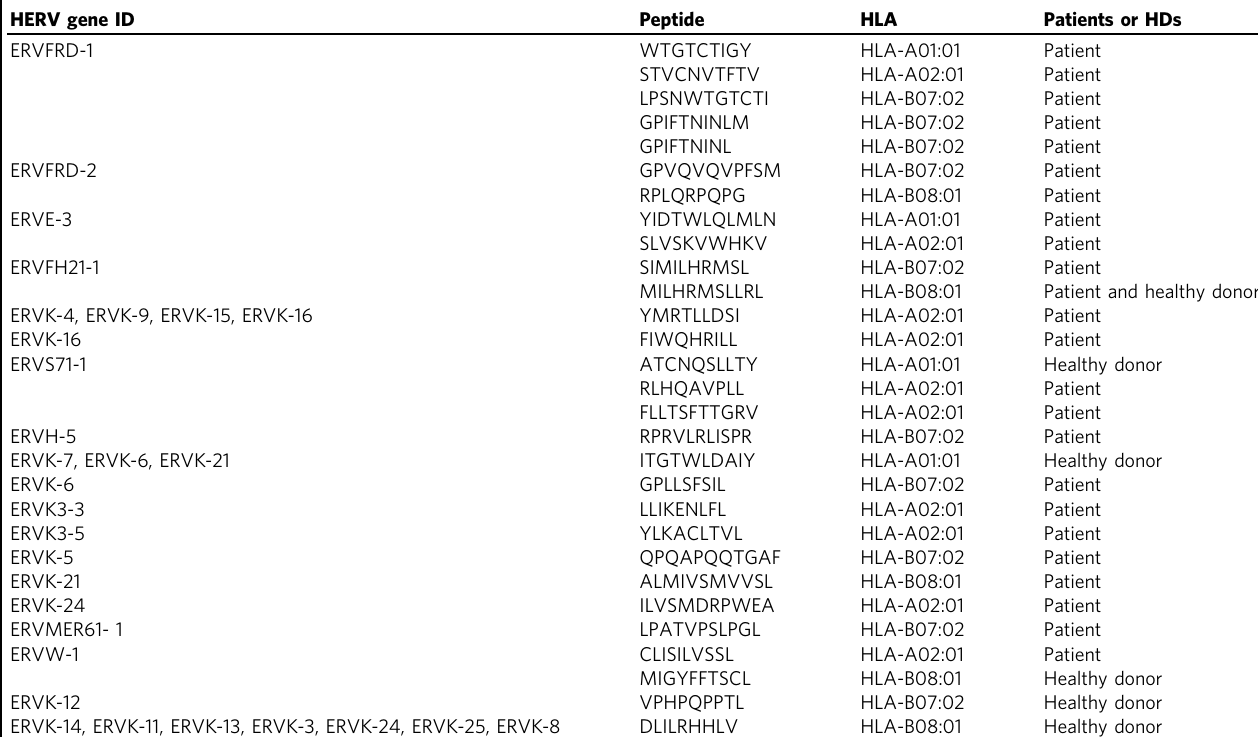
Table 1 HERV-derived T cell epitopes identi fi ed based on CD8 + T cell recognition in patients and healthy donors. HERV gene ID